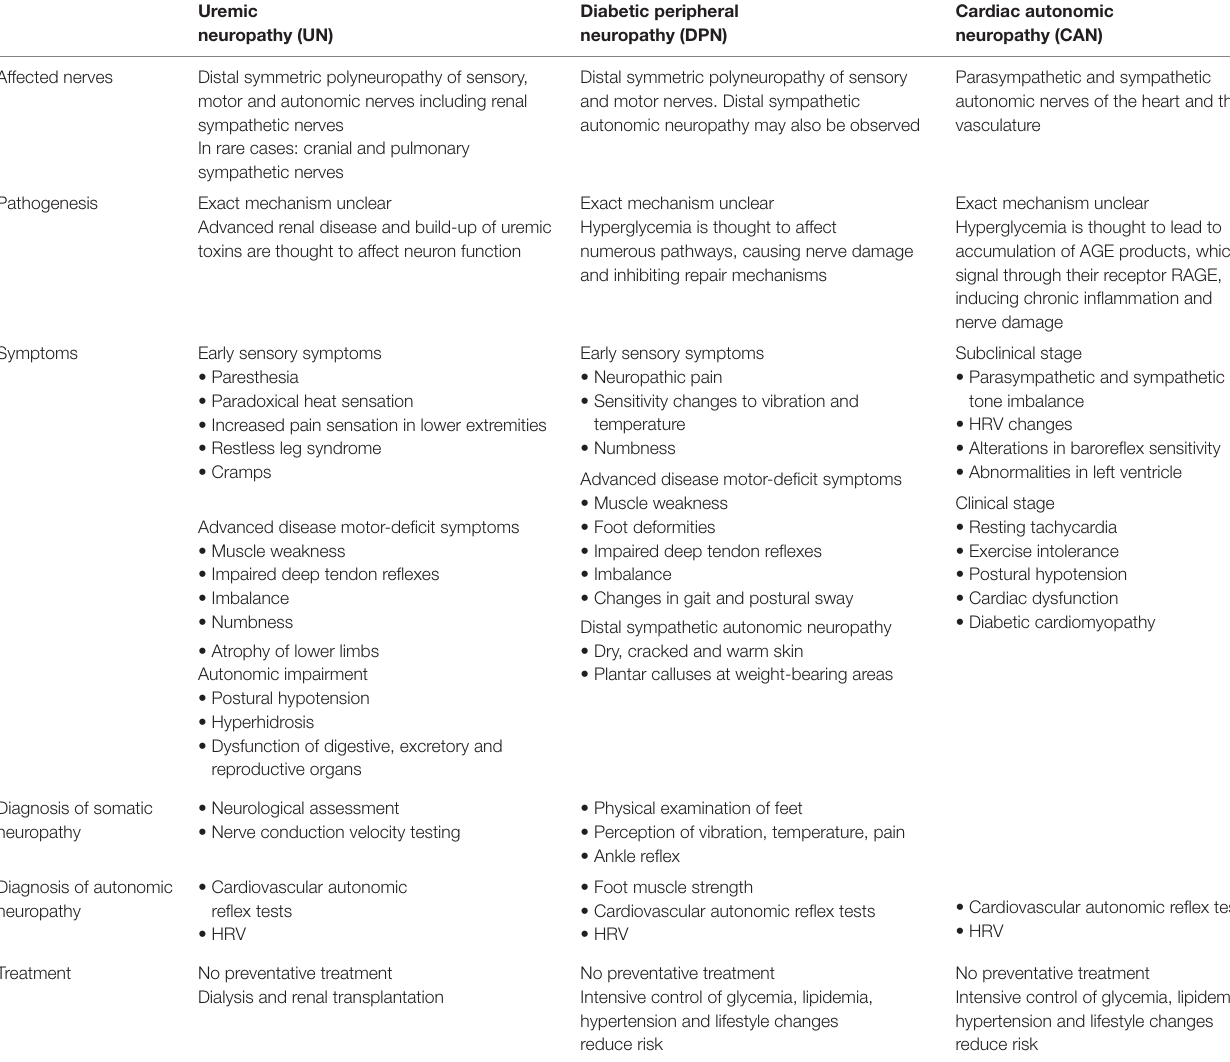
TAble 1 | Clinical presentation and management of the diabetic